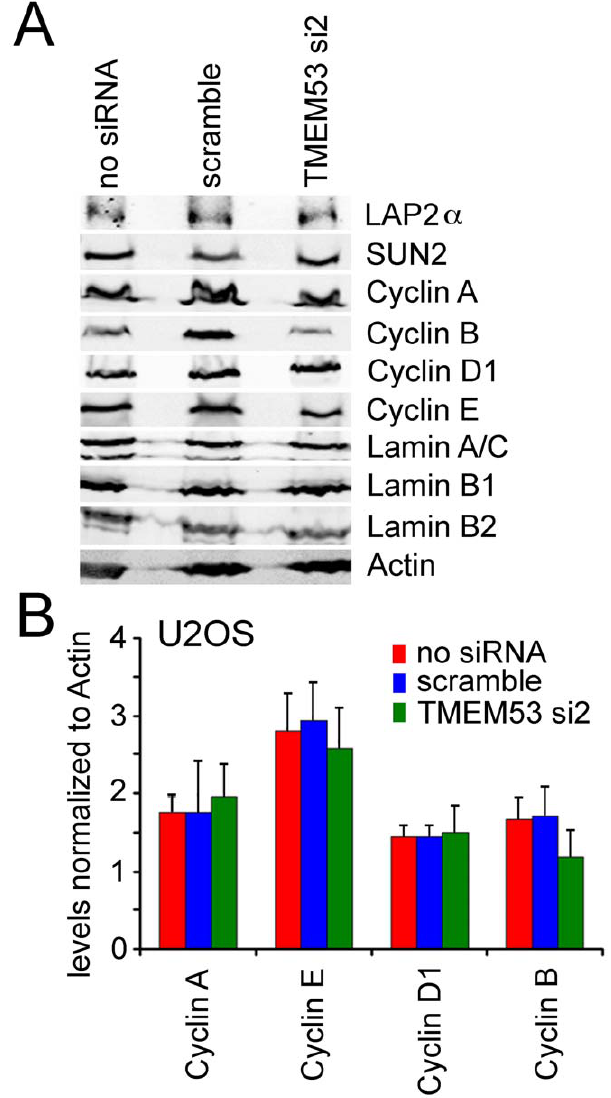
Figure 9. NET4/TMEM53 knockdown did not affect levels of other nuclear envelope proteins linked to the cell cycle or cyclins. (A) Protein lysates were recovered from U2OS cells treated as in Figure 8 and reacted on Western blots with antibodies to the various proteins. This experiment was repeated 3 times and a representative Western blot is shown. (B) Cyclin levels were quantified from three separate experiments analyzed by LI-COR using fluorescent secondary antibodies and are plotted normalized to the actin control. Standard errors are shown.